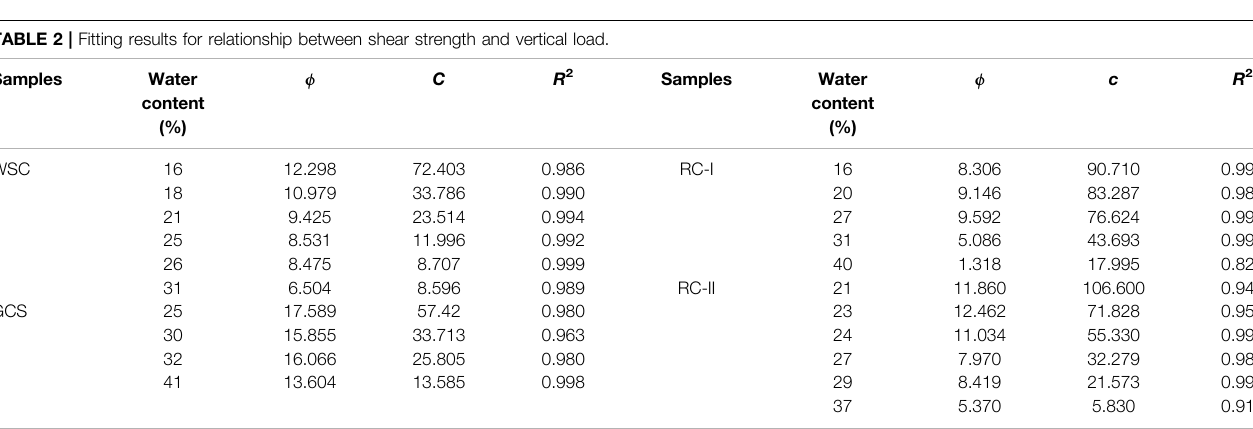
TABLE 2 | Fitting results for relationship between shear strength and vertical load.